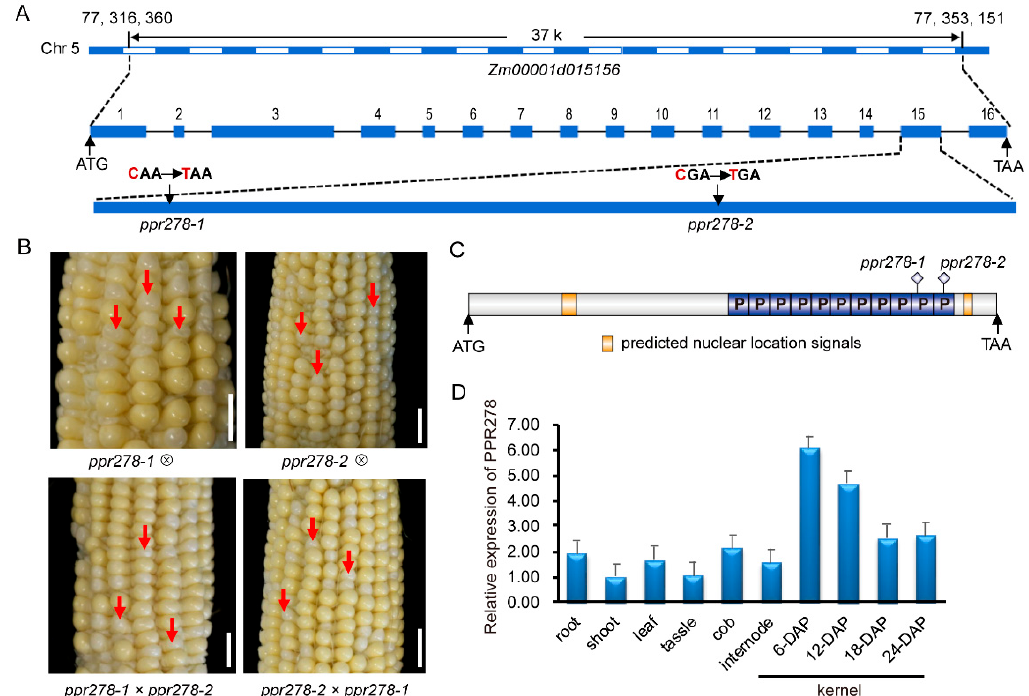
Figure 2. Identification of the ppr278 mutation. ( A ) Schematic of the Zm00001d015156 gene and the location of mutated sites in the ppr278-1 and ppr278-2 mutants. The candidate gene was located on chromosome 5 and identified as Zm00001d015156 , which contains 16 exons (blue rectangles) and 15 introns (black lines). A C-to-T mutation in the 15th exon leads to protein termination at positions 2269 and 2404 bp from the ATG start codon in the ppr278-1 and ppr278-2 mutants, respectively. ( B ) The results of the allelic test of 12-DAP ears of the self-pollinated plants of PPR278/ ppr278-1 , PPR278/ ppr278-2 , PPR278/ ppr278-1 ×PPR278/ ppr278-2 , and PPR278/ ppr278-2 ×PPR278/ ppr278-1 . Red arrows indicate mutant ppr278 seeds. Bar = 1 cm. ( C ) Schematic of PPR278 protein. Blue rectangles represent the p motifs. ( D ) qRT-PCR analysis of relative PPR278 expression in different tissues and kernels at different developmental stages.